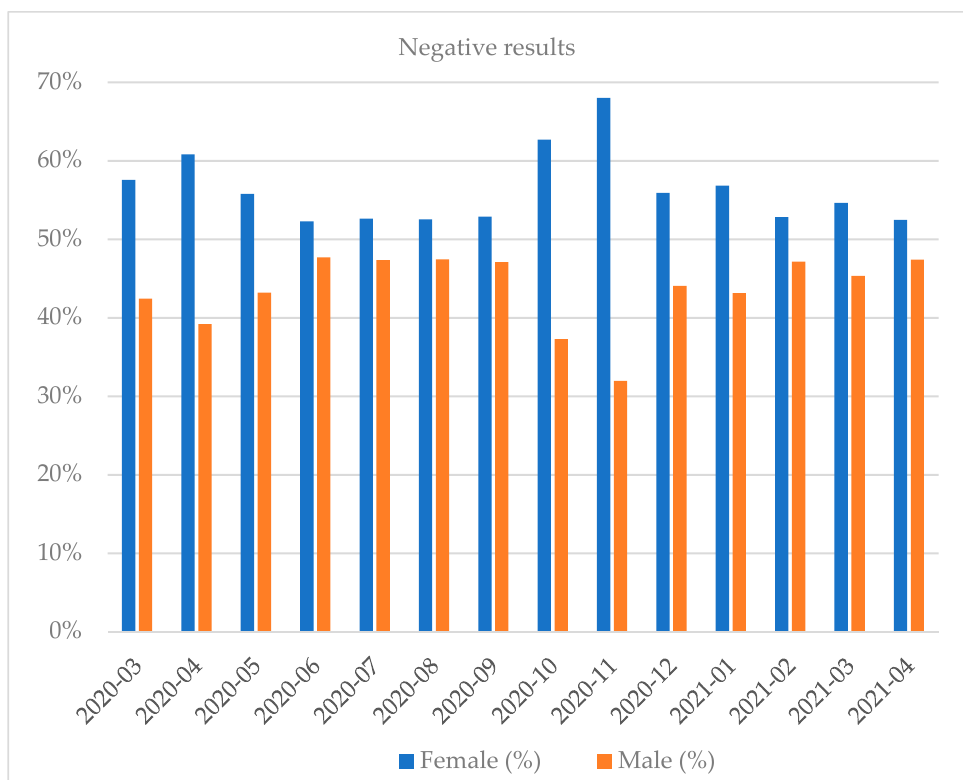
Figure 2. Distribution of negative results by gender in a given month.